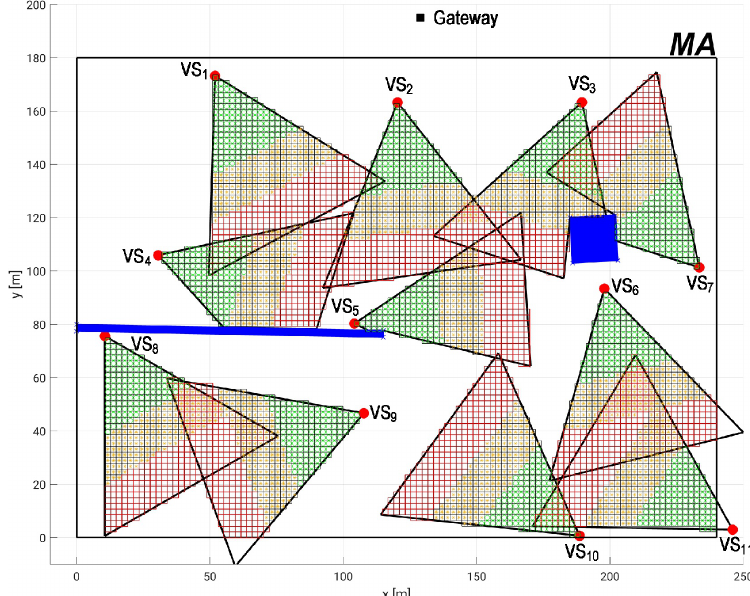
Figure 11. Network deployment considering QoM under visual